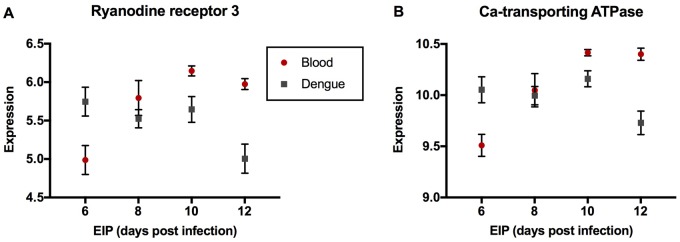
—Genes of enriched GO term GO:0070588 calcium ion transmembrane transport. Expression levels by EIP phenotype of (A) Ryanodine receptor 3 and (B) calcium-transporting ATPase are shown. Expression levels were estimated from read counts from RNAseq data. Red circles depict mosquitoes fed with a naïve blood meal, while gray squares depict those fed with a viremic blood meal. Mean and SEM are shown in graphs (n = 6 per group per treatment).